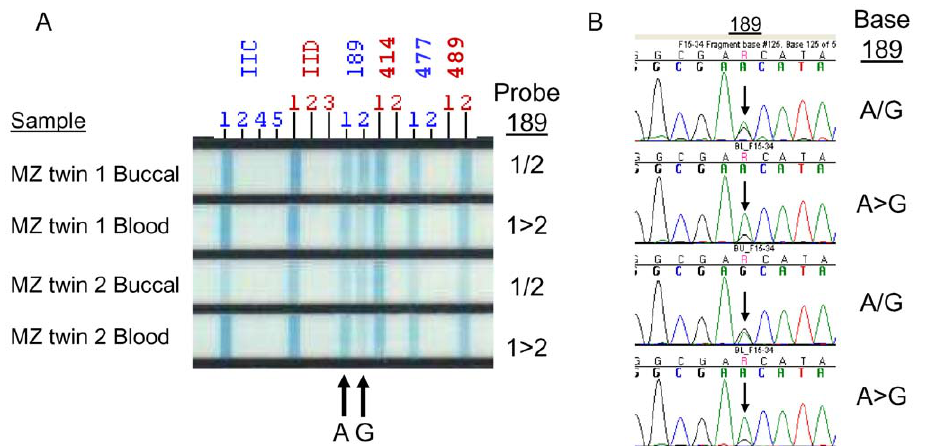
Figure 2. Heteroplasmy at position 189 detected in buccal and blood samples in a monozygotic twin pair aged 60 at the time of the study by A) Linear array assay and B) confirmed by dye terminator sequencing. Two probe signals were observed within the 189 region corresponding to 189 A and G sequence in both the buccal and blood samples of this twin pair. Similar probe signal intensities and peak heights were observed in the buccal samples. The probe signal and sequence peak corresponding to 189 A was greater in the blood samples compared to the 189.